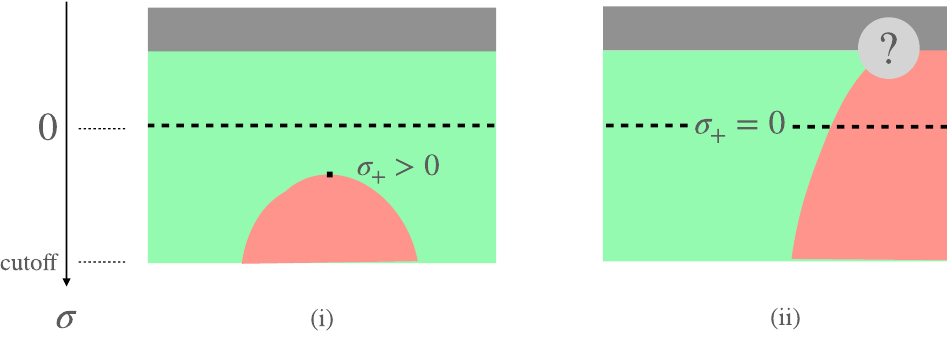
Figure 4 . The two kinds of stationary-wall geometries: (i) The wall avoids the ergoregion, turns around and intersects the AdS boundary twice; or (ii) it enters the ergoregion and does not come out again. The broken line is the ergoplane, the two outer BTZ regions are coloured in green and pink, and the region behind the horizon in grey. The horizon in case (ii) will be described in detail in the coming